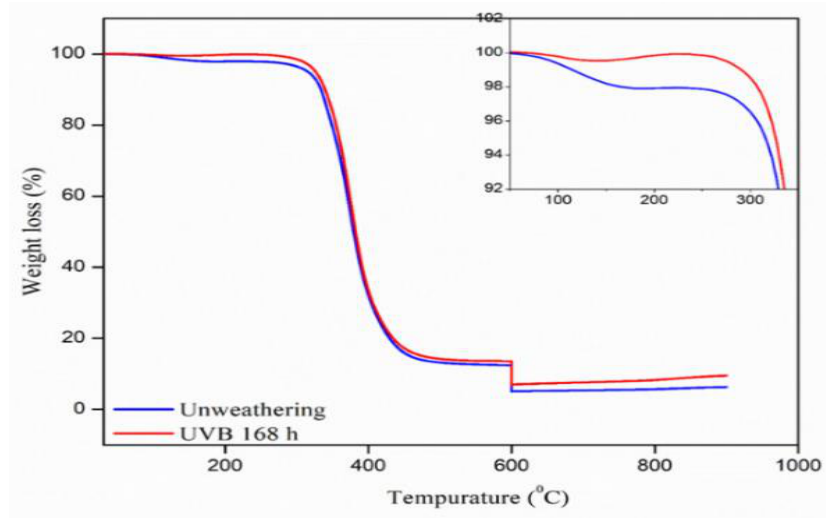
Figure 7. TGA thermograms of nanocomposite samples.